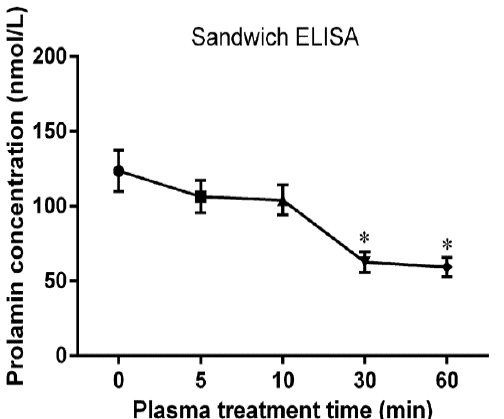
Figure 10. Sandwich ELISA of native and CJAP plasma-modified wheat gliadins. Data are presented as means ± SE ( n = 3) in the ELISA system. Asterisks represent statistically significant differences from 0 min (* p < 0.05).